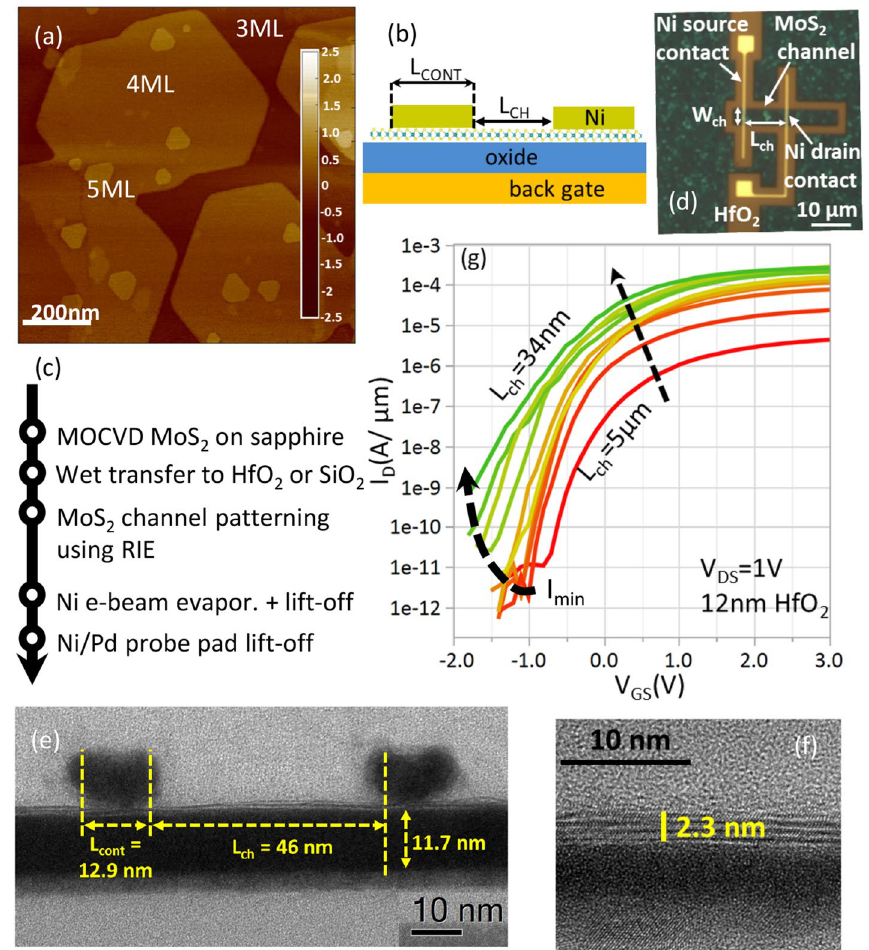
Figure 1. ( a ) Atomic force micrograph of CVD MoS 2 on sapphire template shows a closed 3ML layer with islands of 4 and 5 monolayers distributed randomly. ( b ) Device schematic with global back-gate and top source/ drain contacts. ( c ) Fabrication flow for the back-gated devices. ( d ) Optical micrograph showing the patterned